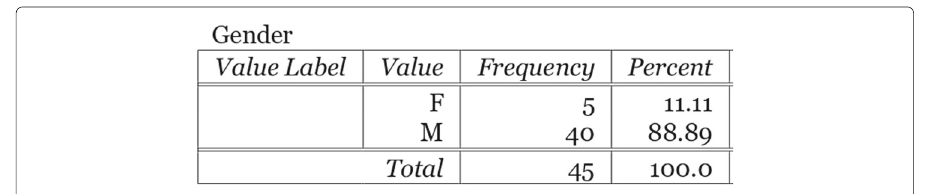
Fig. 11 Gender distribution in the sampled students from evening